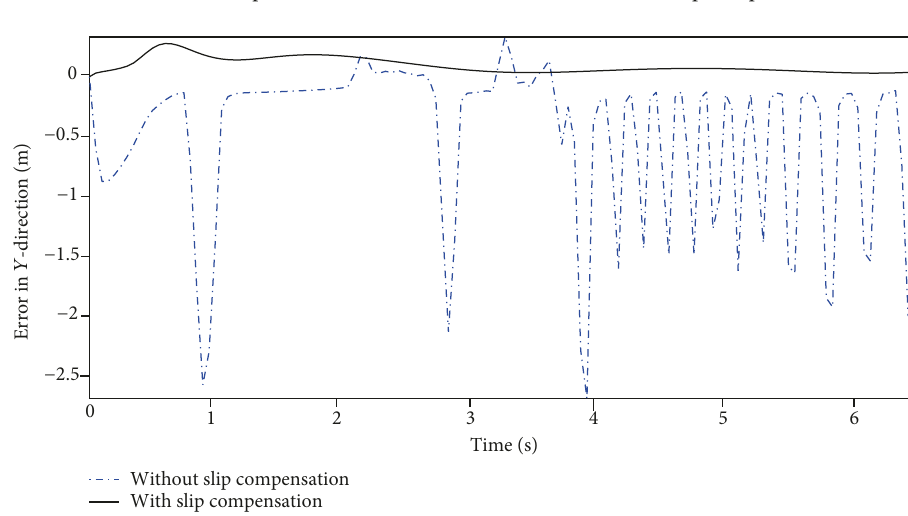
Figure 5: The comparison of error in the X -direction with active slip compensation.